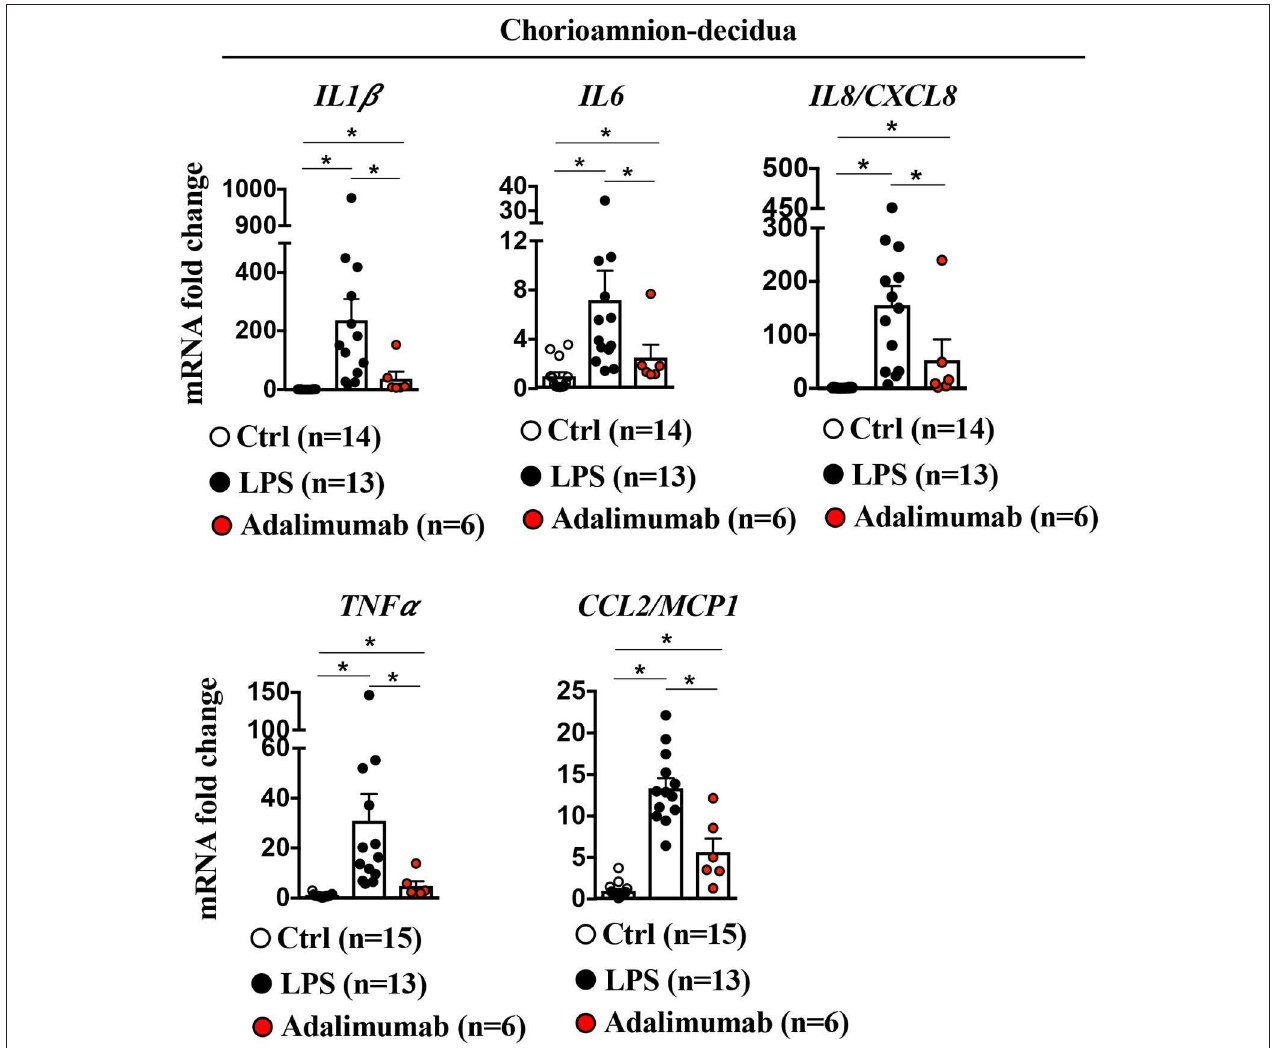
FIGURE 5 | Adalimumab decreased inflammation in the chorioamnion-decidua tissue. Extraplacental chorion-amnion-decidua parietalis tissue (fetal membranes) was used. Expression of cytokine mRNAs by qPCR (Taqman probes) in the fetal membranes showed increased cytokines/chemokines after LPS, which was decreased after Adalimumab. Average mRNA values are fold increases over the average value for control after internally normalizing to the housekeeping 18S RNA (Ctrl n = 14–15; LPS n = 13; Adalimumab n = 6). Data are mean ± SEM, * p < 0.05 vs. controls (Mann–Whitney U